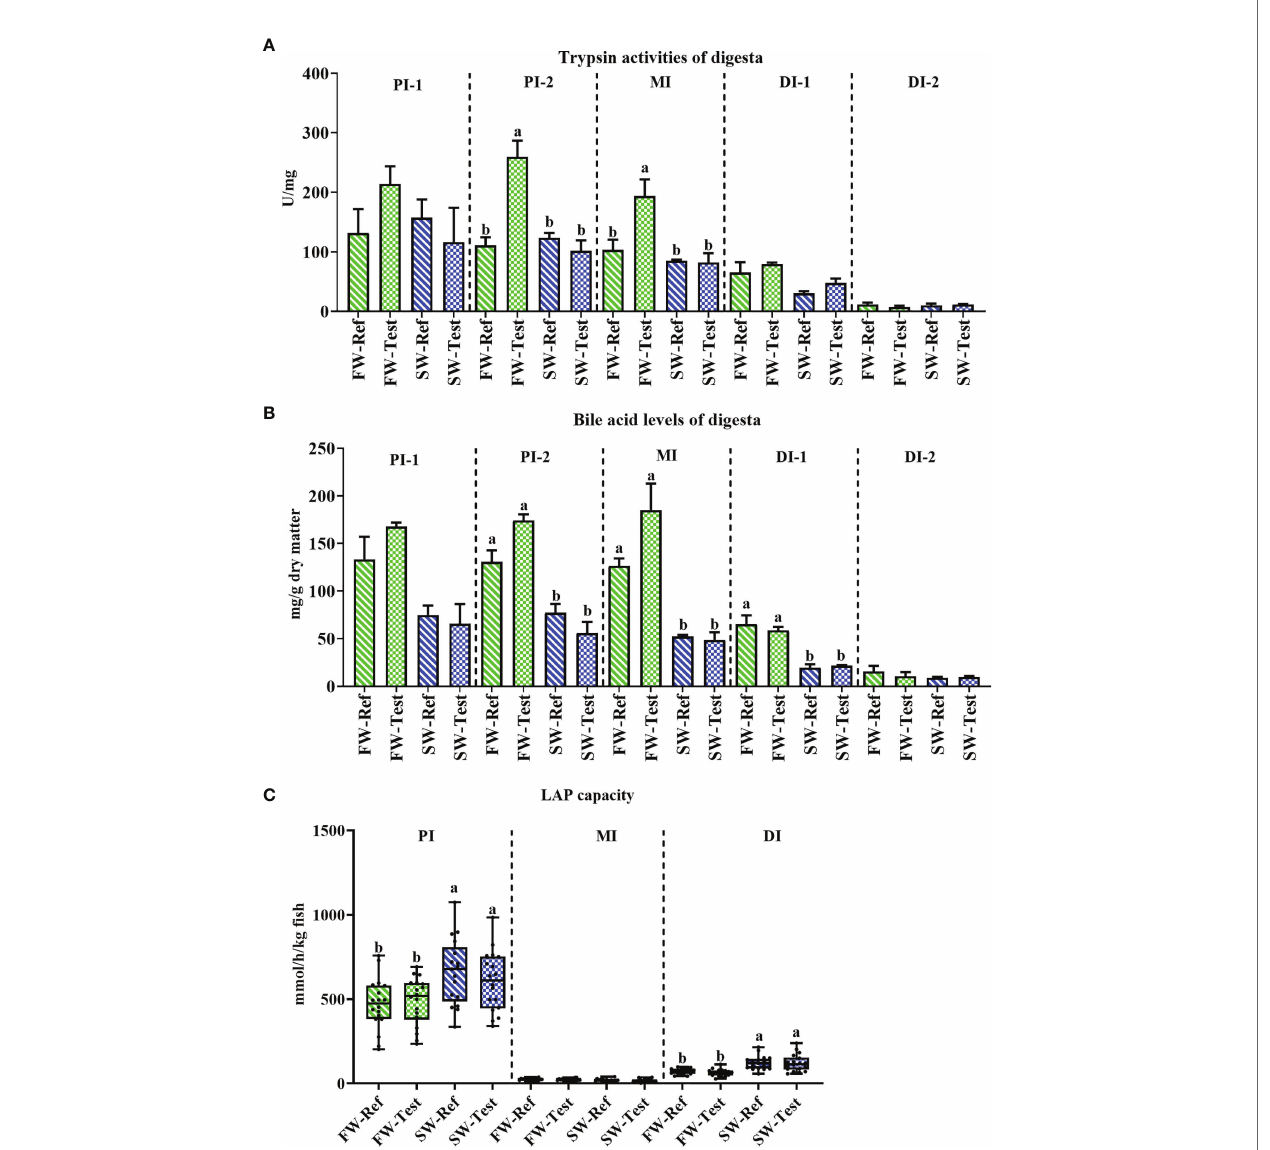
FIGURE 3 | Changes in the digestive enzyme activities and chyme bile salts levels in Atlantic salmon fed different diets before and after the seawater transfer. (A) trypsin activities (n = 3); (B) bile acid level (n = 3); (C) leucine aminopeptidase (LAP) capacity (n = 18). Different letters among values denote signi fi cant differences ( p <. 05) and values sharing the same letters are not signi fi cantly different. PI, proximal intestine; MI, mid intestine DI, distal